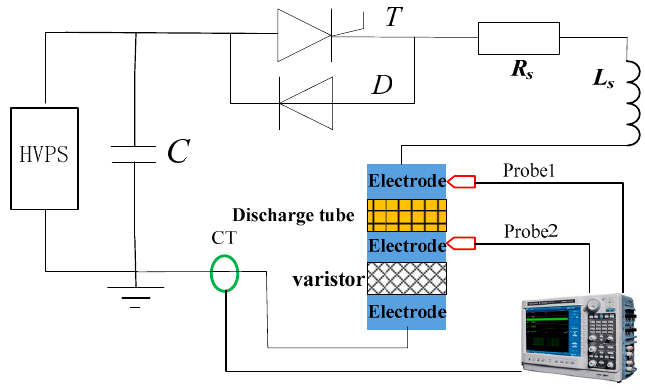
Figure 9. The high current impulse circuit.